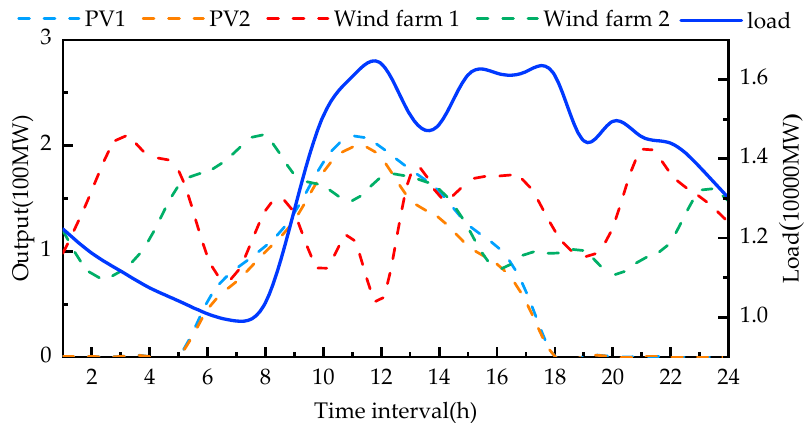
Figure 5. Forecast total daily load, the outputs of two wind farms, and the outputs of two PV units. 5.2. Normalized Normal Constraint (NNC) Method for Solving the First Stage of the Model